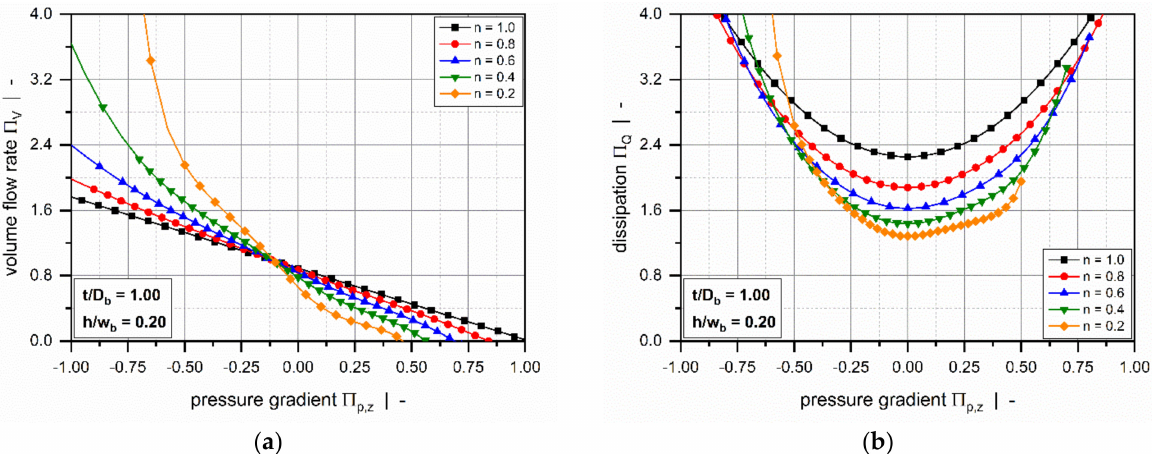
Figure 10. Influence of the power-law index on a fully developed three-dimensional flow of a power- law fluid in a screw channel of finite width under isothermal conditions. The dimensionless volume flow rate Π V as a function of the dimensionless pressure gradient Π p , z ( a ), and the dimensionless dissipation Π Q as a function of the dimensionless pressure gradient Π p , z ( b ).